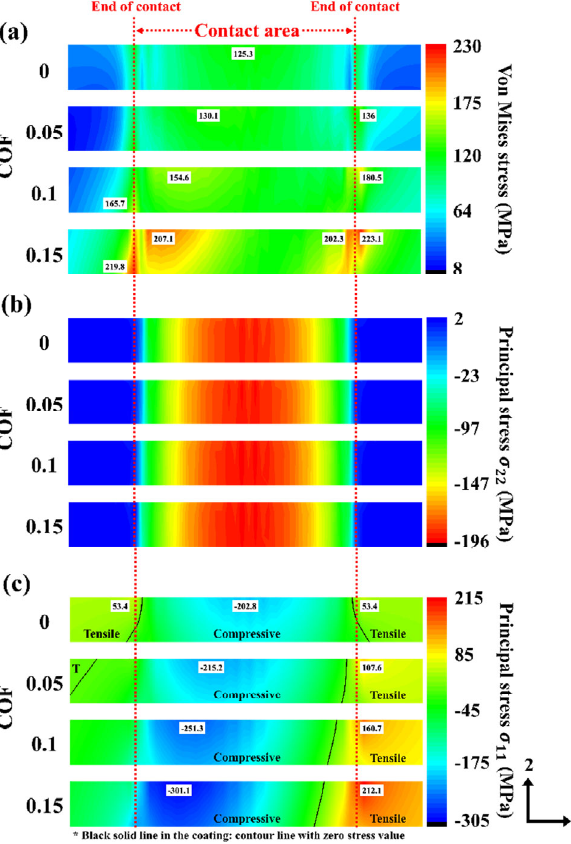
Fig. 7 Stress distribution of the coating at the pitch point with various COFs: (a) von Mises stress, (b) principal stress in the normal, and (c) tangential directions (1 and 2 in the coordinate system represent tangential and normal directions with respect to the contact area of the coating at the pitch